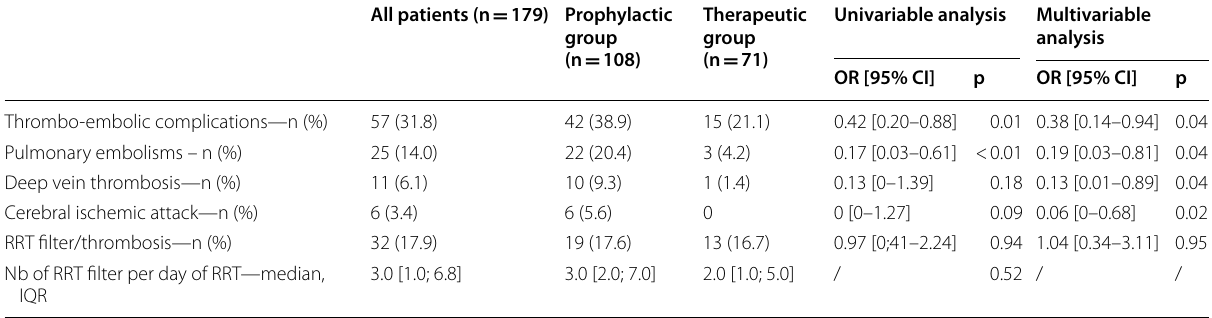
CI confidence interval, IQR interquartile range, OR odds ratio, RRT renal replacement therapy